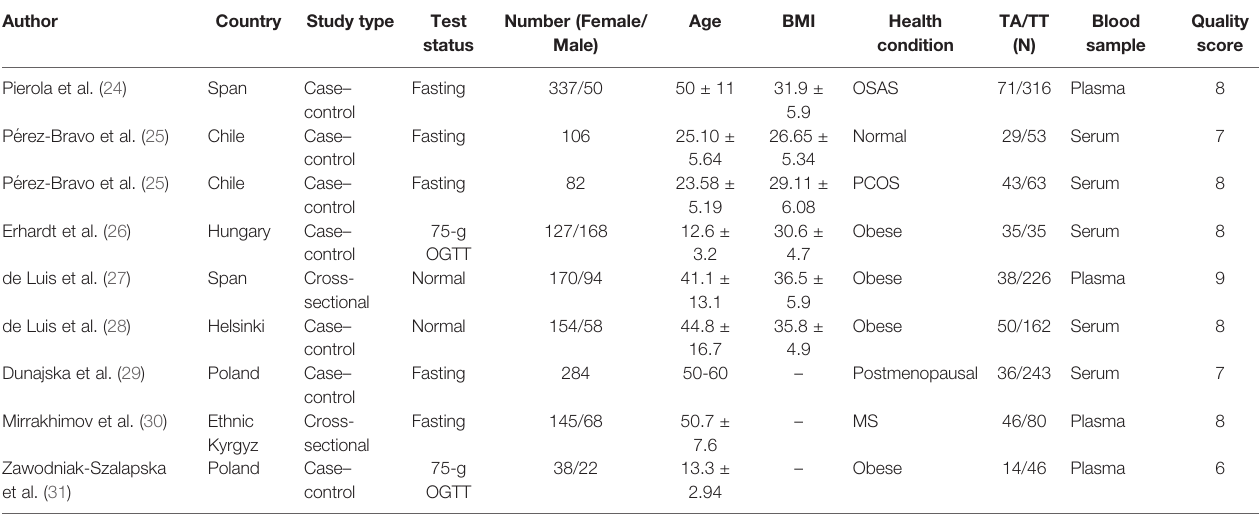
TABLE 1 | Characteristics of included studies.